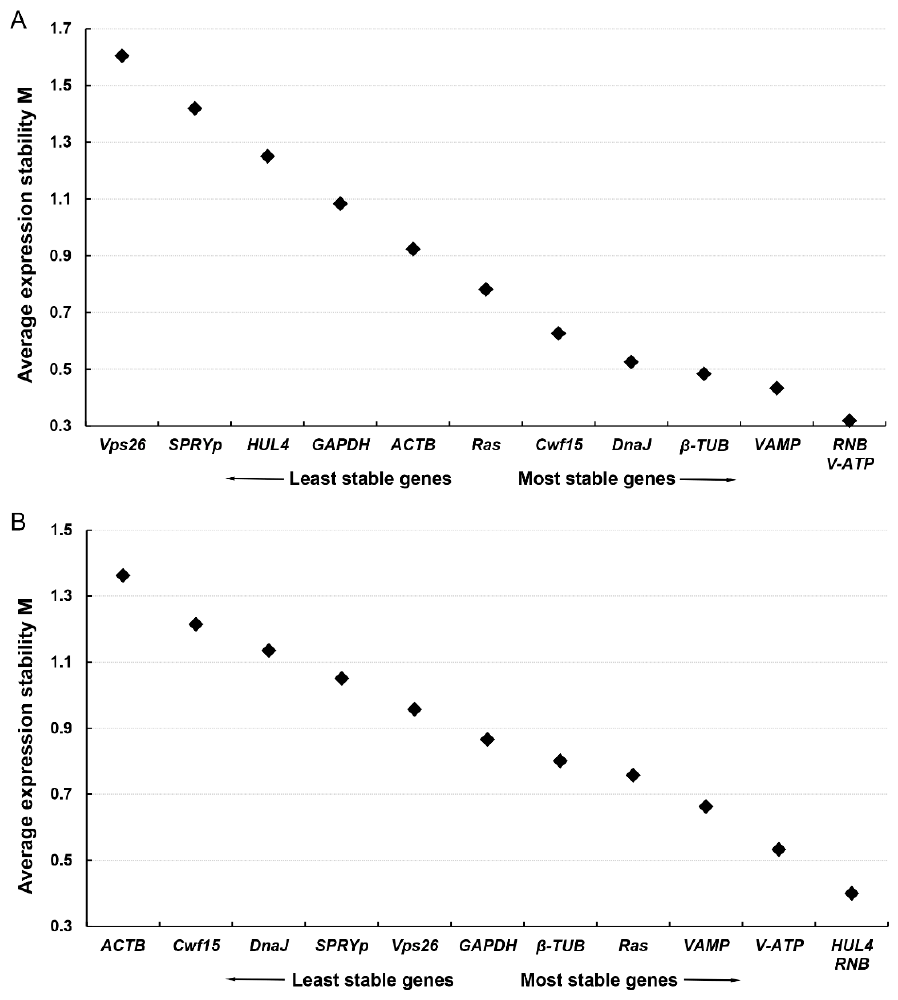
Figure 3. The expression stability ranking of 12 ICGs candidates using geNorm in F. filiformis and N. crassa . The stability measure M values, calculated by geNorm, were shown on the y-axis. The lowest M values represent the most stable expression. ( A ) The expression stability ranking of 12 ICGs candidates in F. filiformis . ( B ) The expression stability ranking of 12 ICGs candidates in N. crassa .